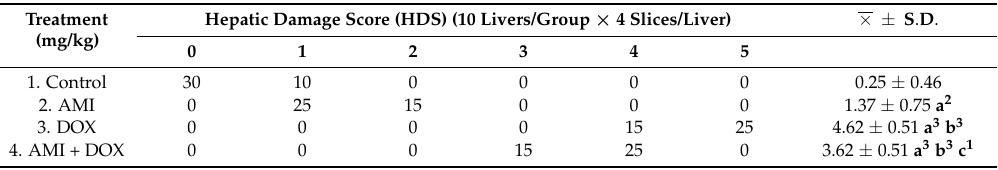
Table 4. The effects of different treatments on the degree of hepatic alterations 28 days after receiving last treatment. Treatment (mg/kg)